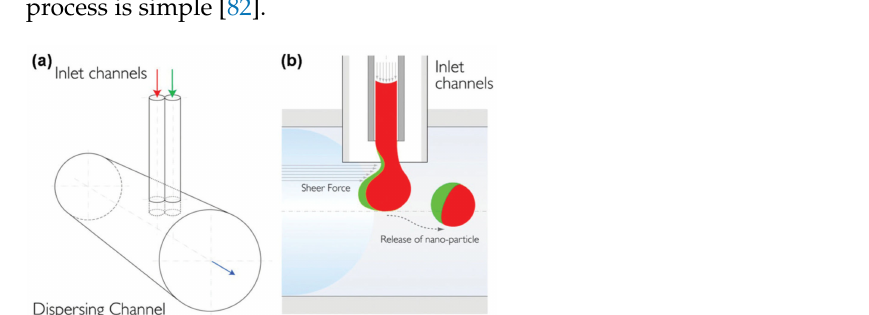
Figure 3. Schematic of the modified fluidic nanoprecipitation system (FNPS). ( a ) Cartoon of FNPS. Sample inlets are inserted into the dispersing channel via a “T” connector. The inlet channels contain two PLGA polymers that make contact at the exit of the inlet streams and precipitate upon contact with the surfactant in the dispersing channel, solidifying the particles. ( b ) Side view of the channels. PLGA droplets are exposed to the hydrodynamic force of the continuous flow. Reprinted with permission from ref. [80]. Copyright © 2012 American Chemical